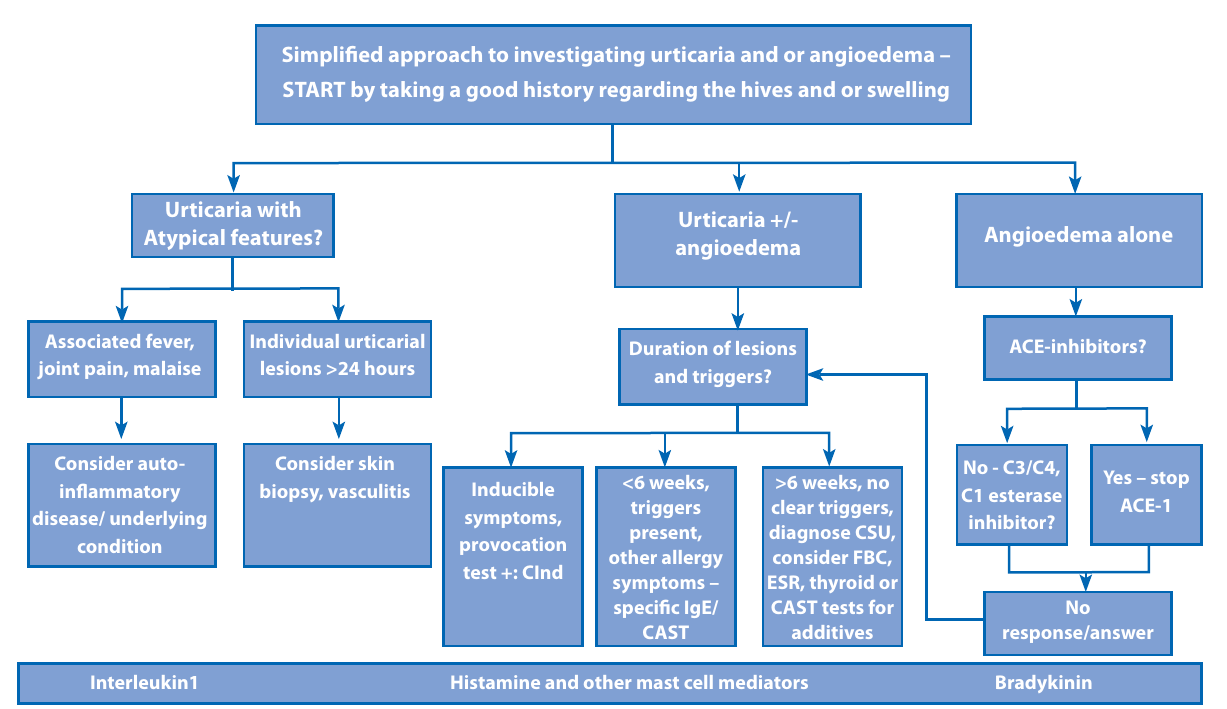
Figure 1. Approach to investigation of urticaria and angioedema, adapted by the author from EAACI/GA 2 LEN/EDF/WAO 2013 guideline diagnosis algorithm.